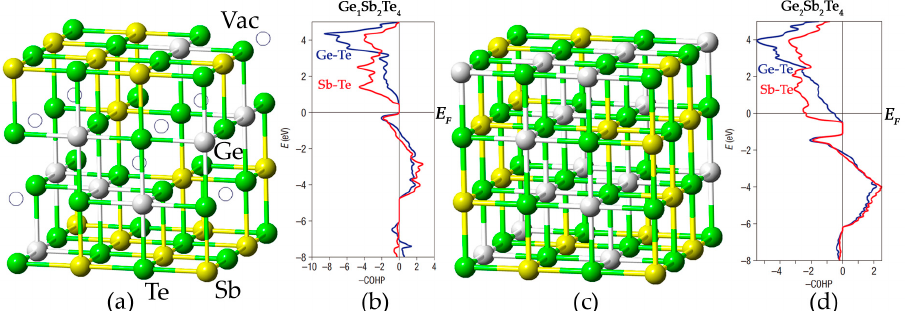
Figure 1. Cubic rocksalt structures of ( a ) Ge 1 Sb 2 Te 4 and ( c ) Ge 2 Sb 2 Te 4 . Atomic vacancies, Ge, Sb and Te atoms are rendered with hollow circles, grey, yellow and green spheres, respectively. The crystal orbital Hamilton population (COHP) bonding analyses of Ge 1 Sb 2 Te 4 and Ge 2 Sb 2 Te 4 are shown in ( b , d ), where the negative values (of –COHP) represent antibonding interactions (left side), while positive values represent bonding ones (right side). The Ge–Te and Sb–Te contacts are shown in blue and red, respectively. Adapted with permission from Reference [45] © 2007 Nature Publishing Group.